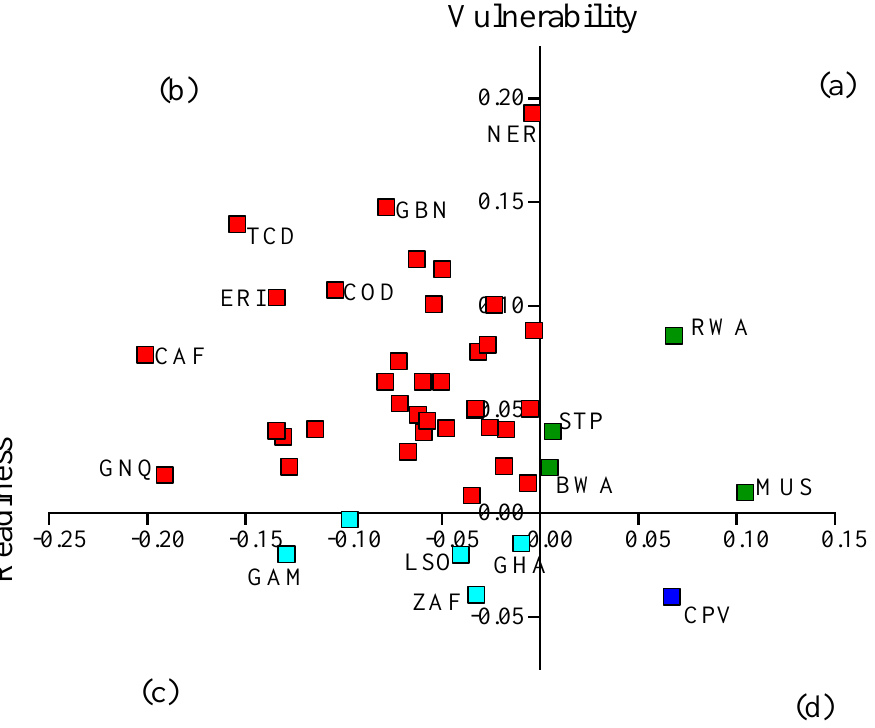
Figure 5. Comparisons of countries in SSA vulnerability and readiness to climate risks: ( a ) high vulnerability and high readiness, ( b ) high vulnerability and low readiness, ( c ) low vulnerability and low readiness, and ( d ) low vulnerability and high readiness.